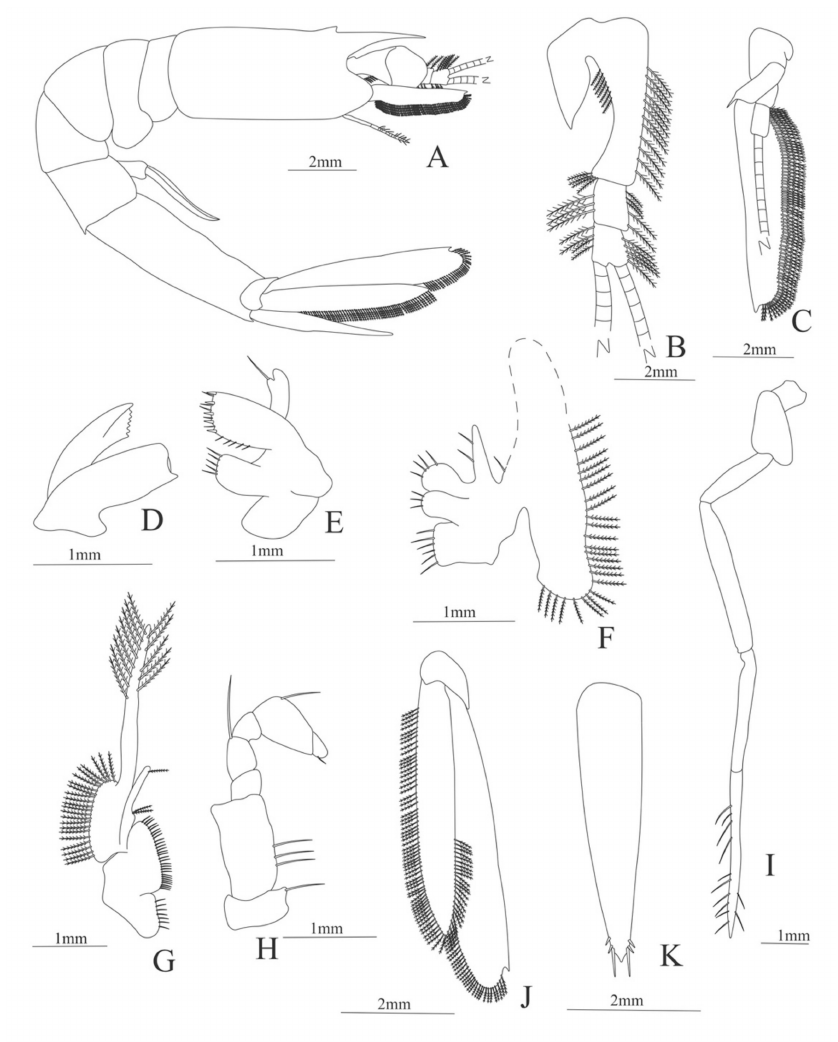
Figure 4. Meningodora longisulca : ( A ) lateral view; ( B ) antennule; ( C ) antenna, ( D ) mandible; ( E ) maxillule; ( F ) maxilla; ( G ) first maxilliped; ( H ) second maxilliped; ( I ) third maxilliped; ( J ) uropods; ( K )